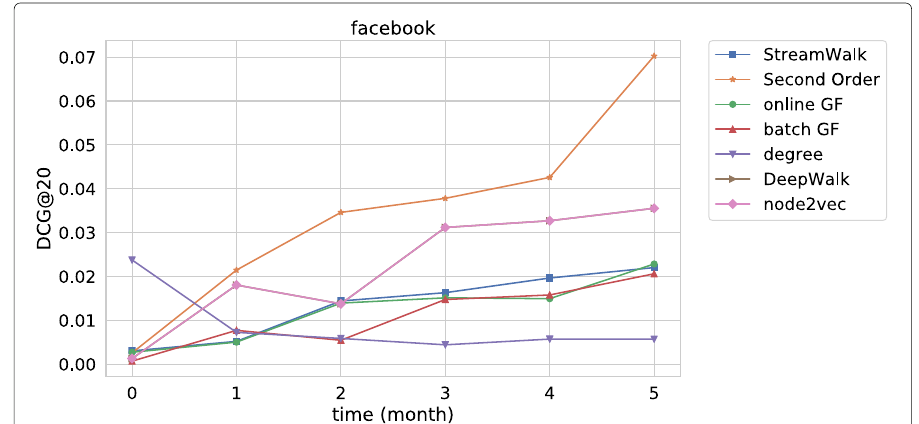
Fig. 15 Comparison of the batch and online methods for the link prediction problem on the Facebook data